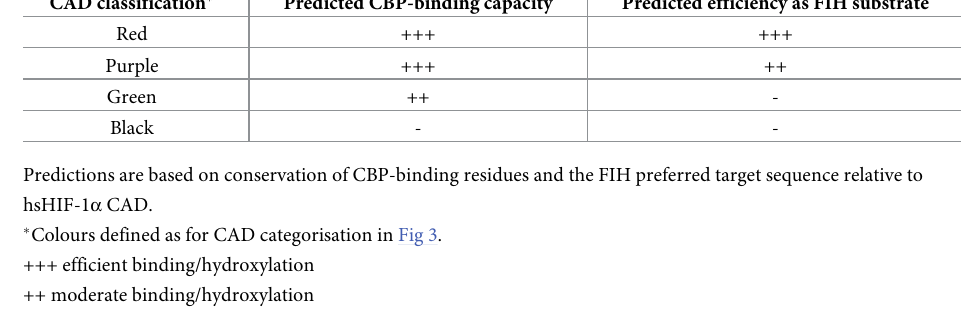
Table 1. Predicted CBP and FIH-binding capacity of HIF- α CAD homologs.